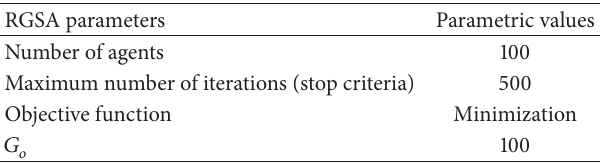
Table 2: Parameters of refined GSA